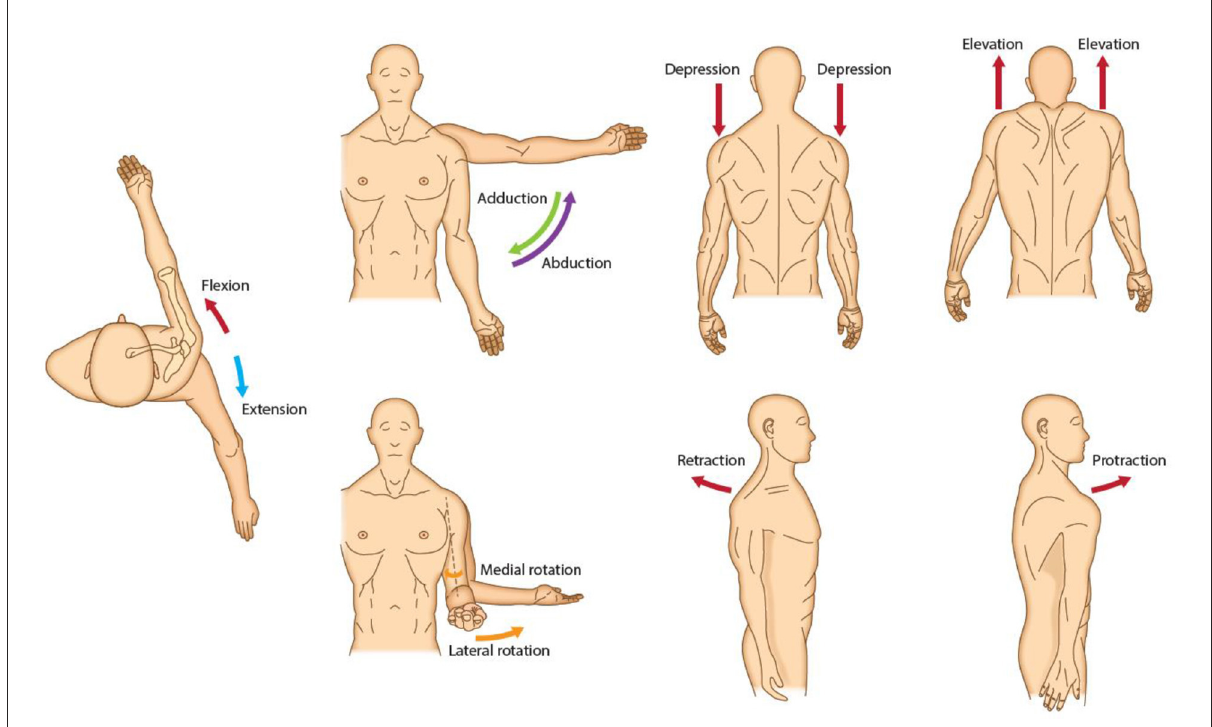
FIGURE1 Upper limb degrees of freedom at shoulder.